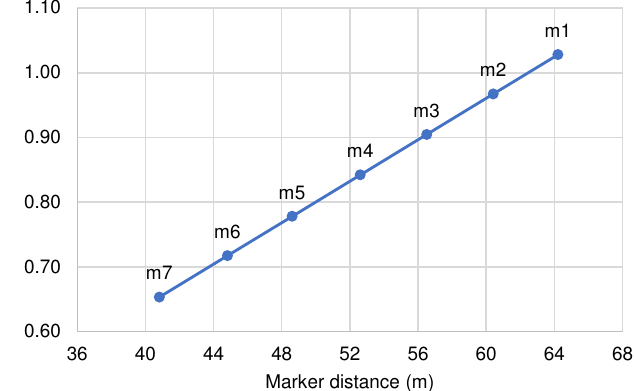
Figure 5. Scaling factor for each marker at different distances defines the ratio between actual physical displacement and perceived pixelwise movement in the captured image. The value was calibrated from the known object size of the printed marker